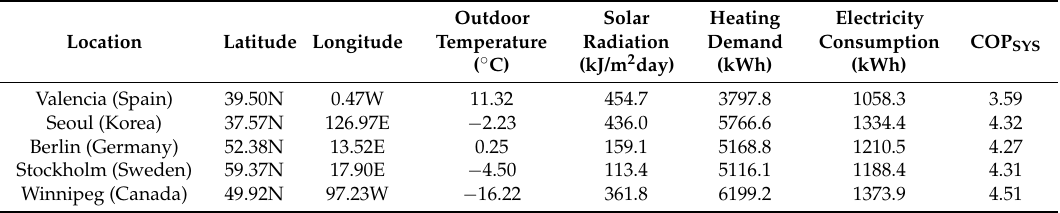
Table 5. Simulation results according to the five different climate conditions.